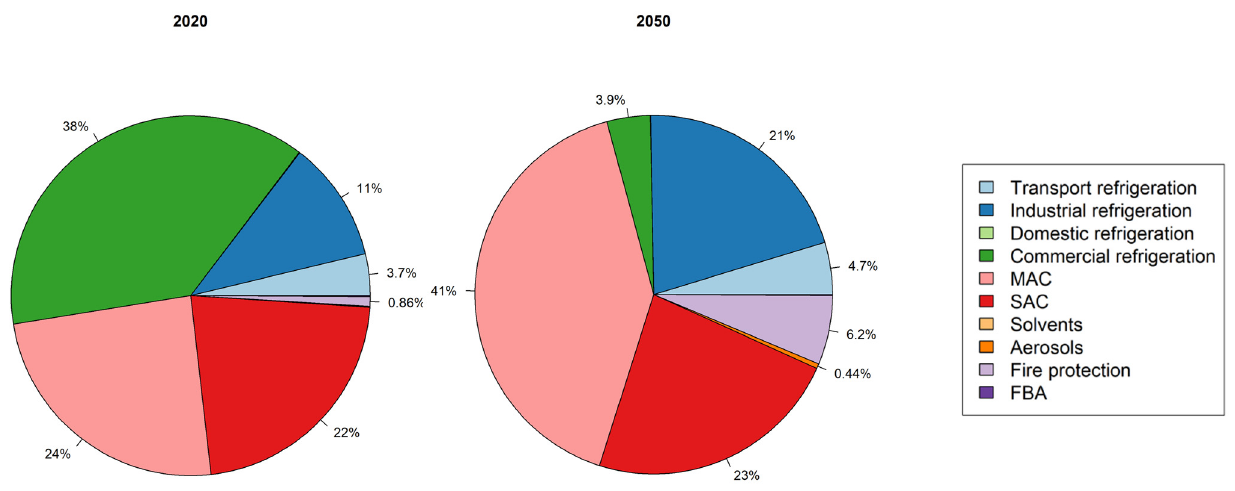
Figure 3. F-gas emission shares for years 2020 and 2050 based on kt CO 2 eq. Categories with share 0.1% and less are not shown.